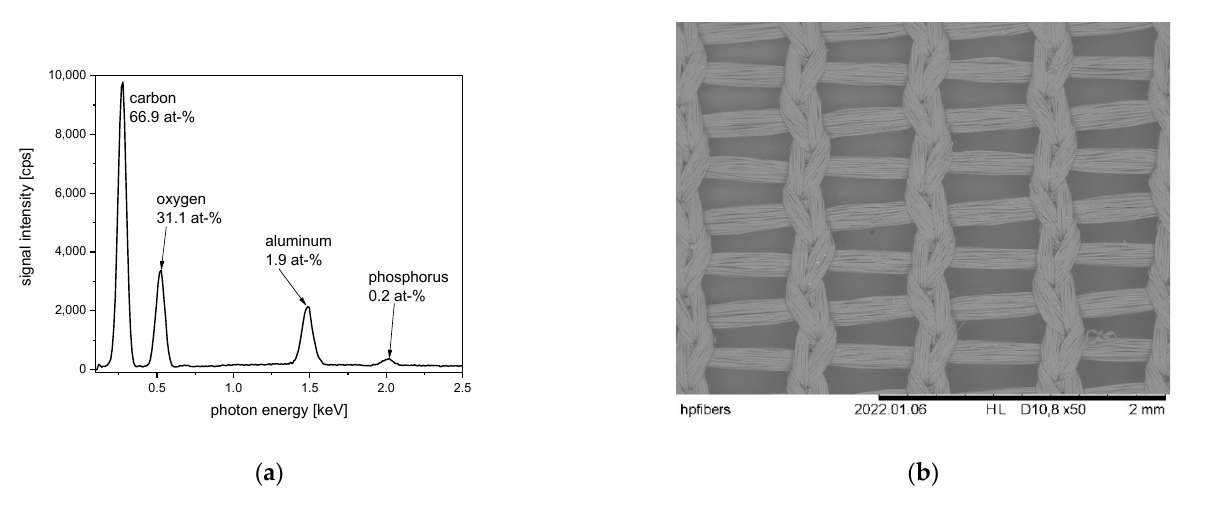
Figure 42. Presentation of a commercially available fabric with aluminum plating (product from Creation Baumann AG, Langenthal, Switzerland): ( a ) EDS spectrum of this fabric with detected chemical elements and their determined concentration; ( b ) SEM image.